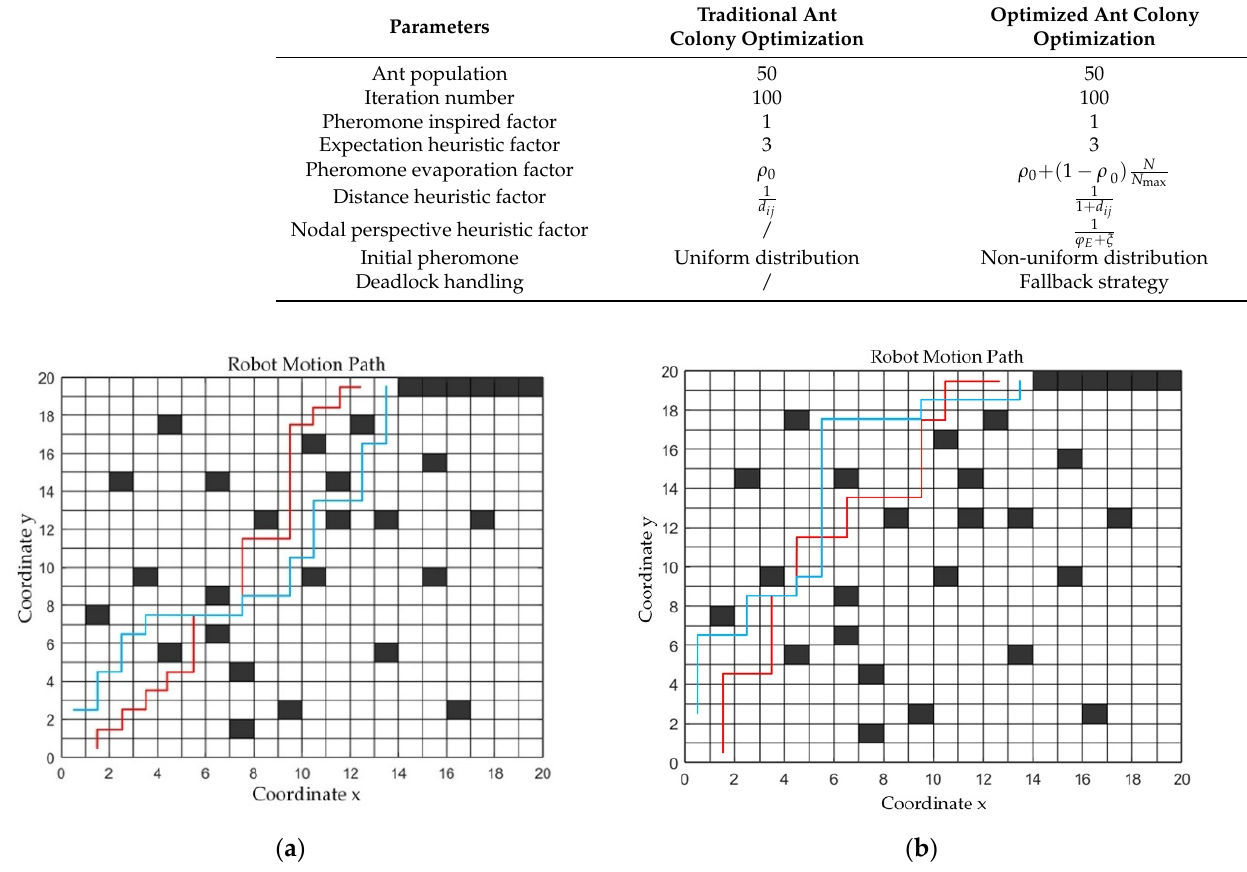
Table 3. Comparison of algorithm parameter settings.